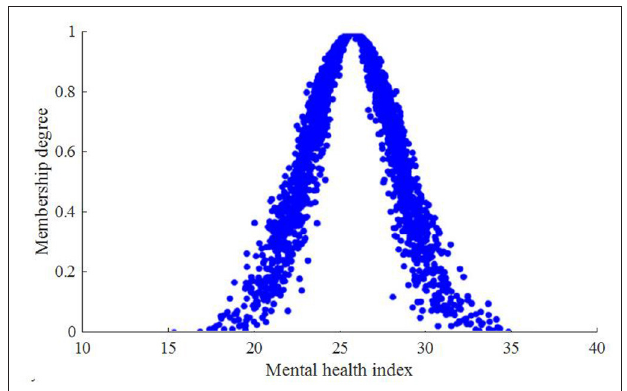
FIGURE 3 | Probability of forming mental problem for community workers involved in the prevention of COVID-19 epidemic.